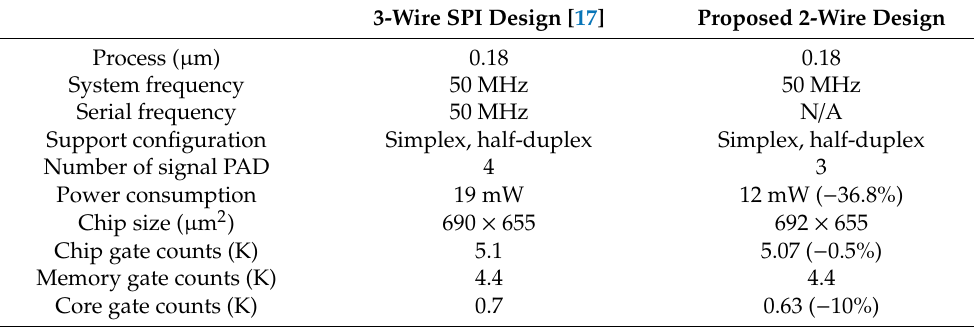
Table 4. Comparison of the three-wire and proposed two-wire